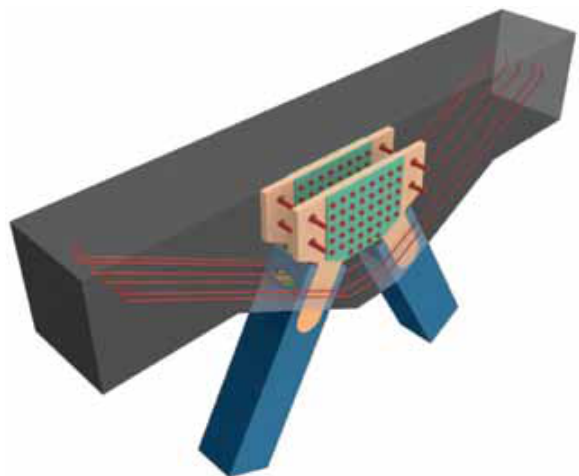
Fig. 2. Structure of